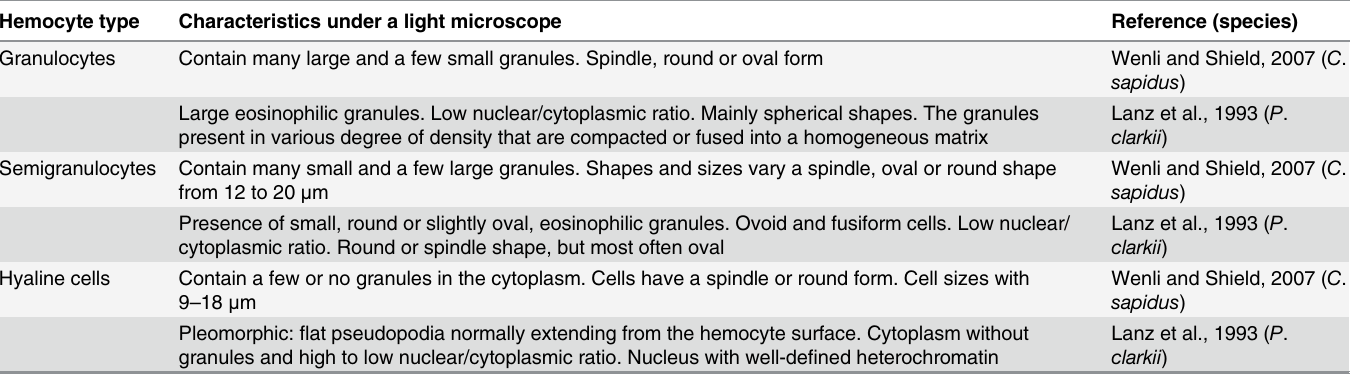
Table 1. Properties of the different hemocyte types of C . sapidus and other decapod crustaceans. Hemocyte type Characteristics under a light